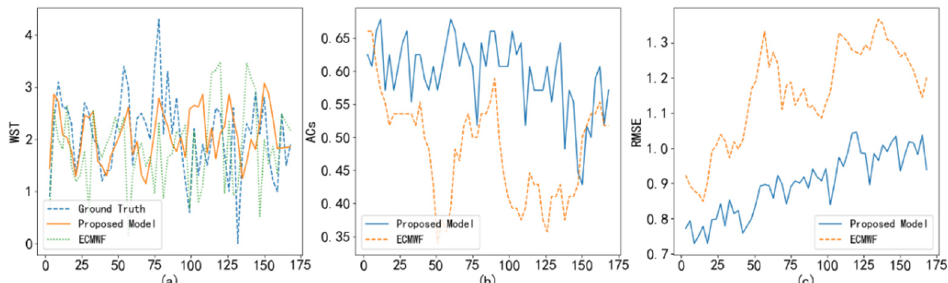
Figure 6. Comparison of the ECWMF model and the proposed method in terms of their wind forecast at Haikou Station: ( a ) real wind speed versus ECWMF prediction and proposed correction; ( b ) AC s index comparison; ( c ) RMSE index comparison.